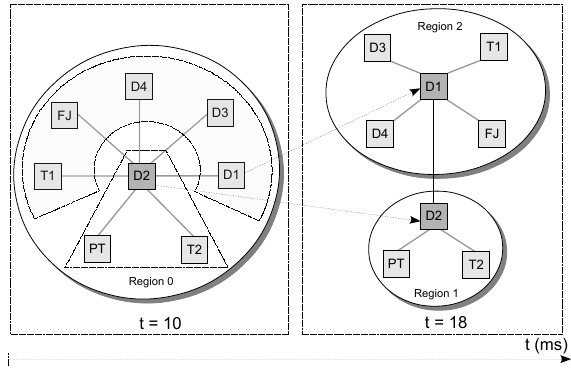
Figure 11. The self-organizing process of the platform